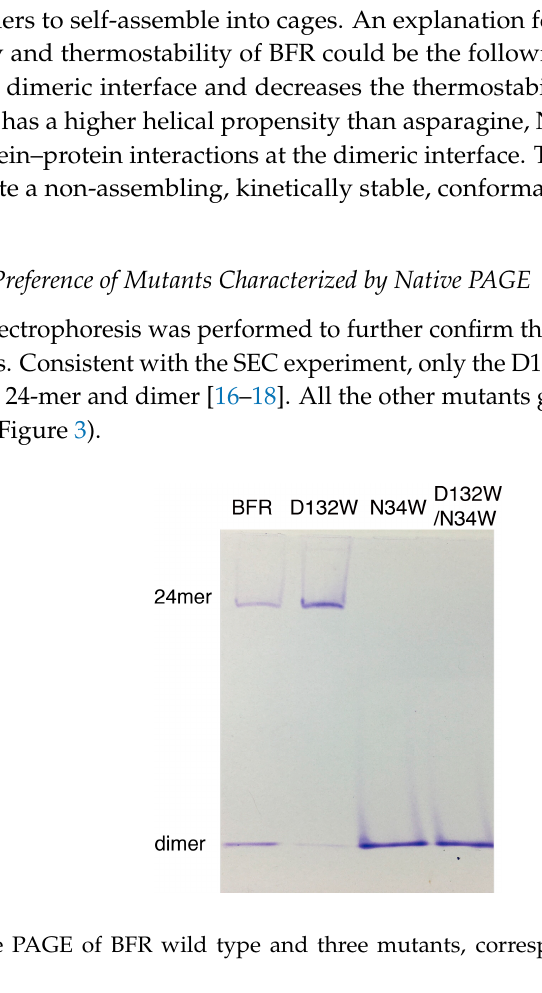
Table 1. Average particle diameters of three BFR-derived mutants at B-site interface.